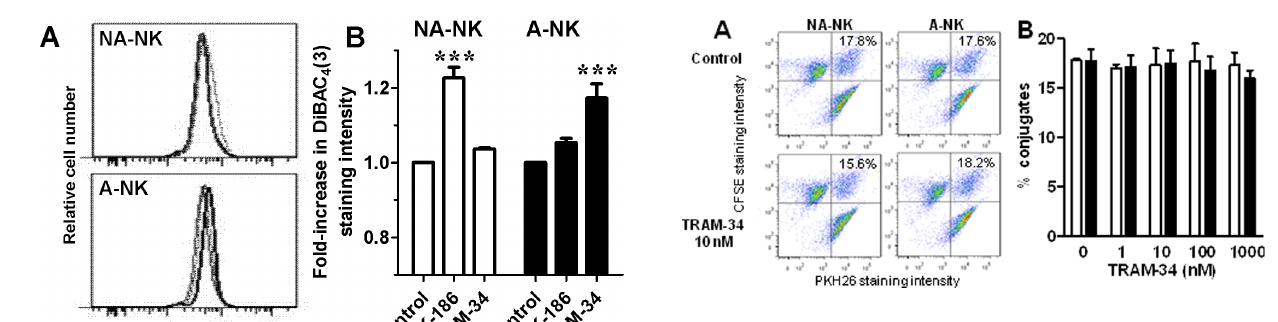
Figure 7. TRAM-34 does not affect the formation of conjugates between NK and K562 cells. A: Representative dot-plots with double positive signals representing the conjugates formed by NK and K562 cells, the percent of conjugates are indicated in each condition. B: Percent of NK:K562 conjugates obtained in absence or presence of 1 m M TRAM-34 for A-NK (black) and NA-NK (white). Data represent the mean 6 SEM of data obtained with cells from 6 donors. *p , 0.05, **p , 0.01, ***p ,